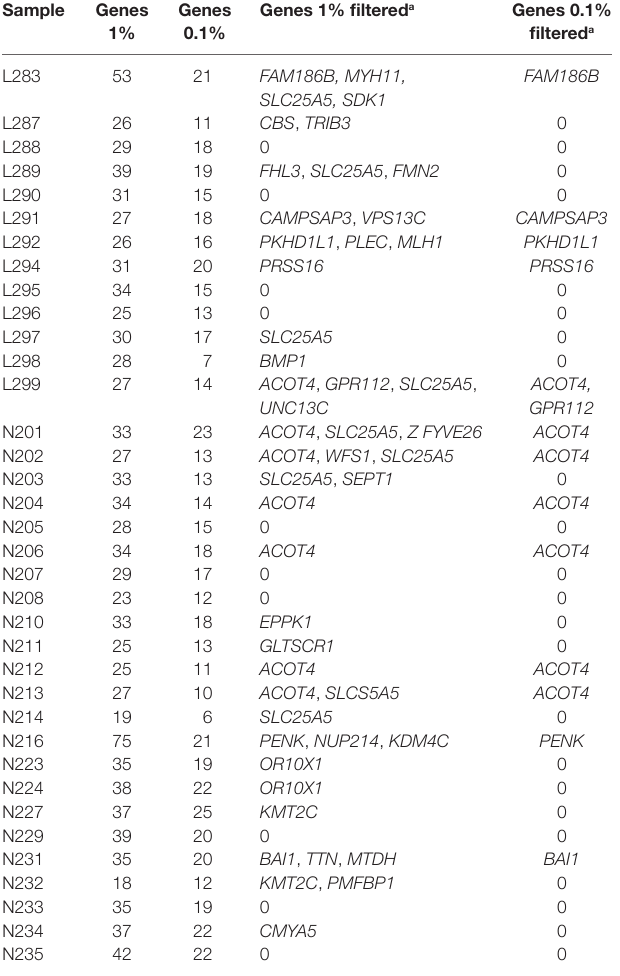
TaBle 6 | Patients with rare functional variants (MAF < 0.01) and GERP > 2 in a common variable immunodeficiency (CVID) candidate gene and interacting proteins.